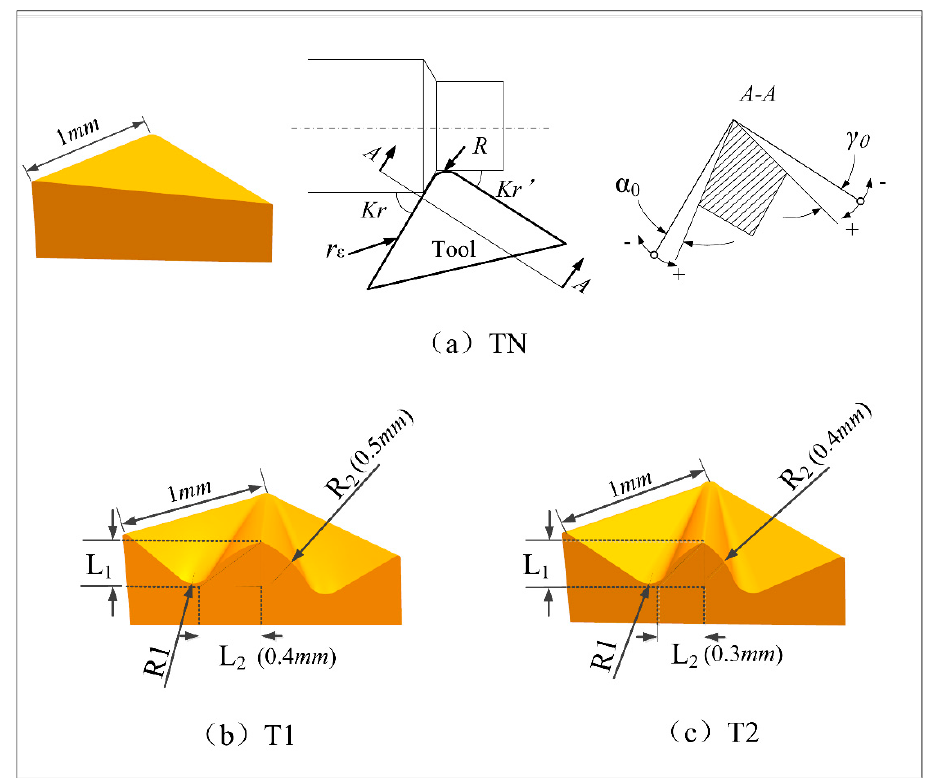
Figure 1. Different surface tool models and their surface parameters: ( a ) Plane tool-TN, ( b ) curved tool-T1, and ( c ) curved tool-T2.